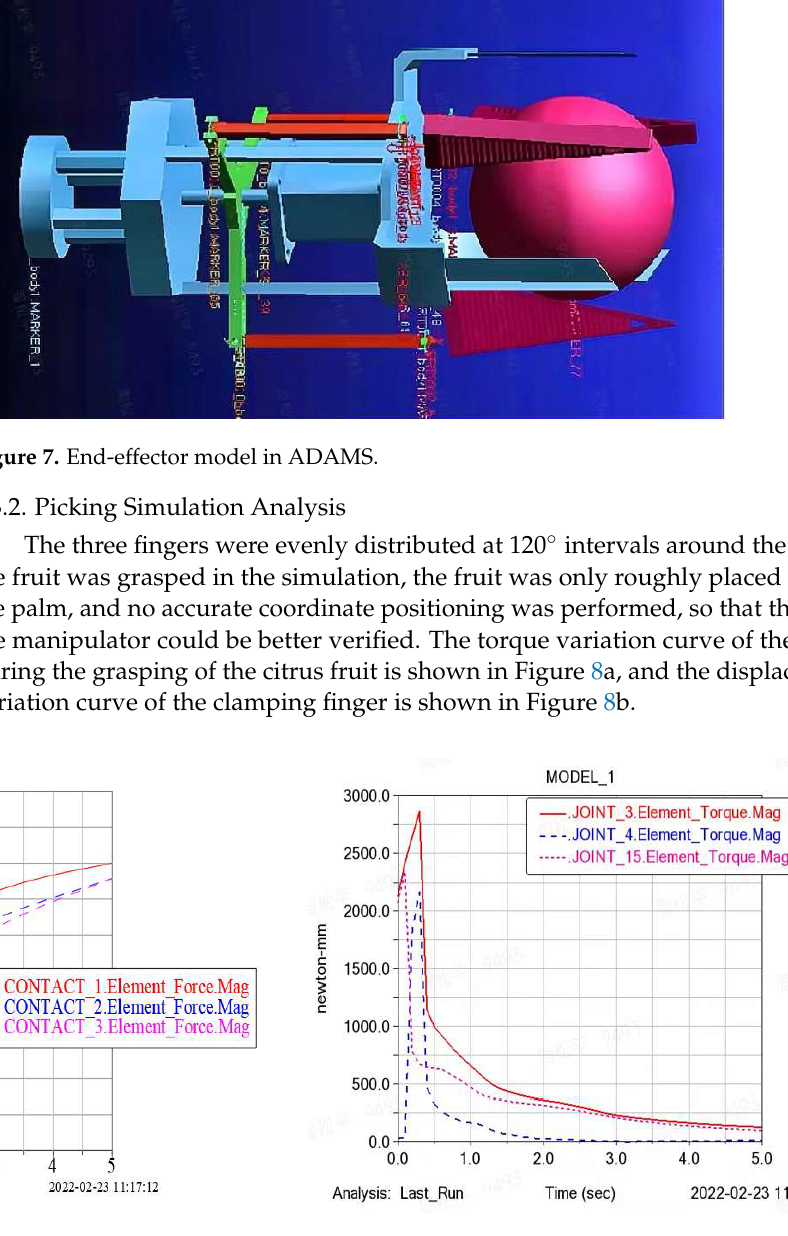
Figure 8. Simulation analysis diagram. ( a ) Flexible finger torque variation graph; ( b ) Clamping fin- ger displacement velocity variation graph.